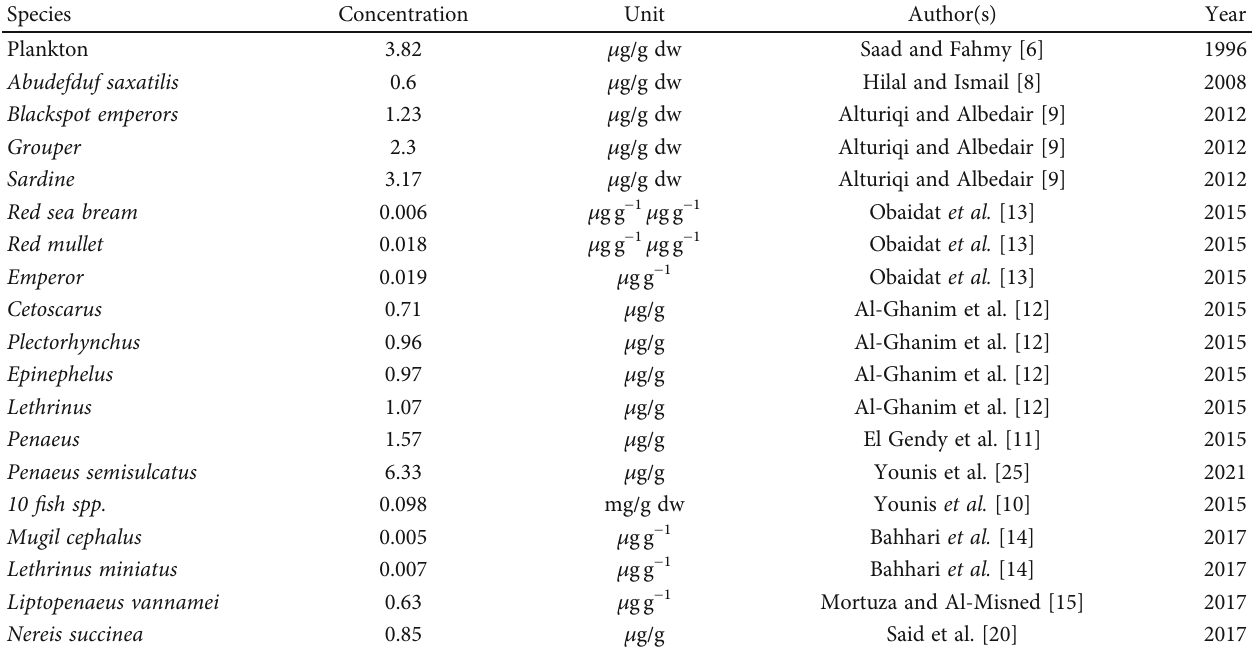
Table 1: Bioaccumulation of cadmium reported from the Red Sea.